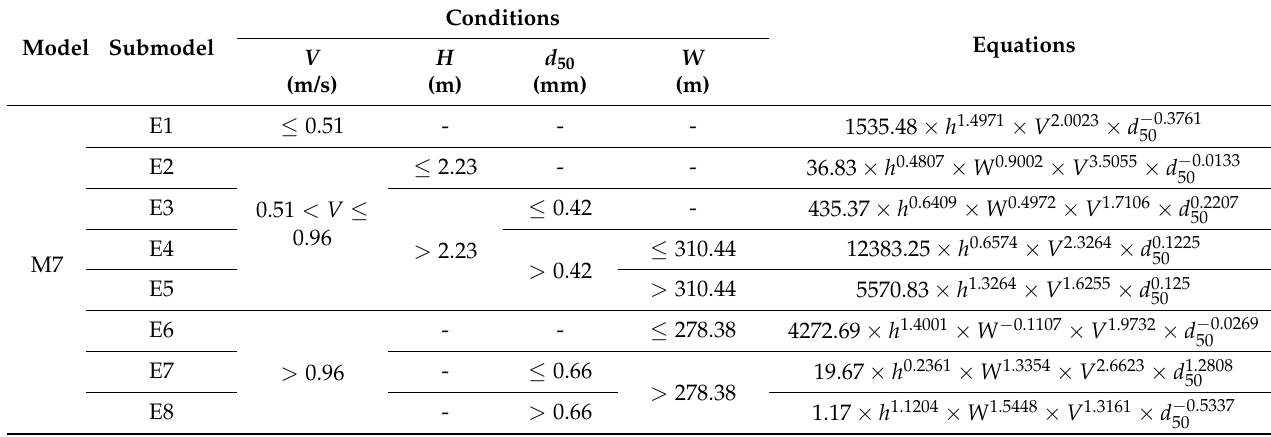
Table 7. Application conditions and determination coefficients of Model 7